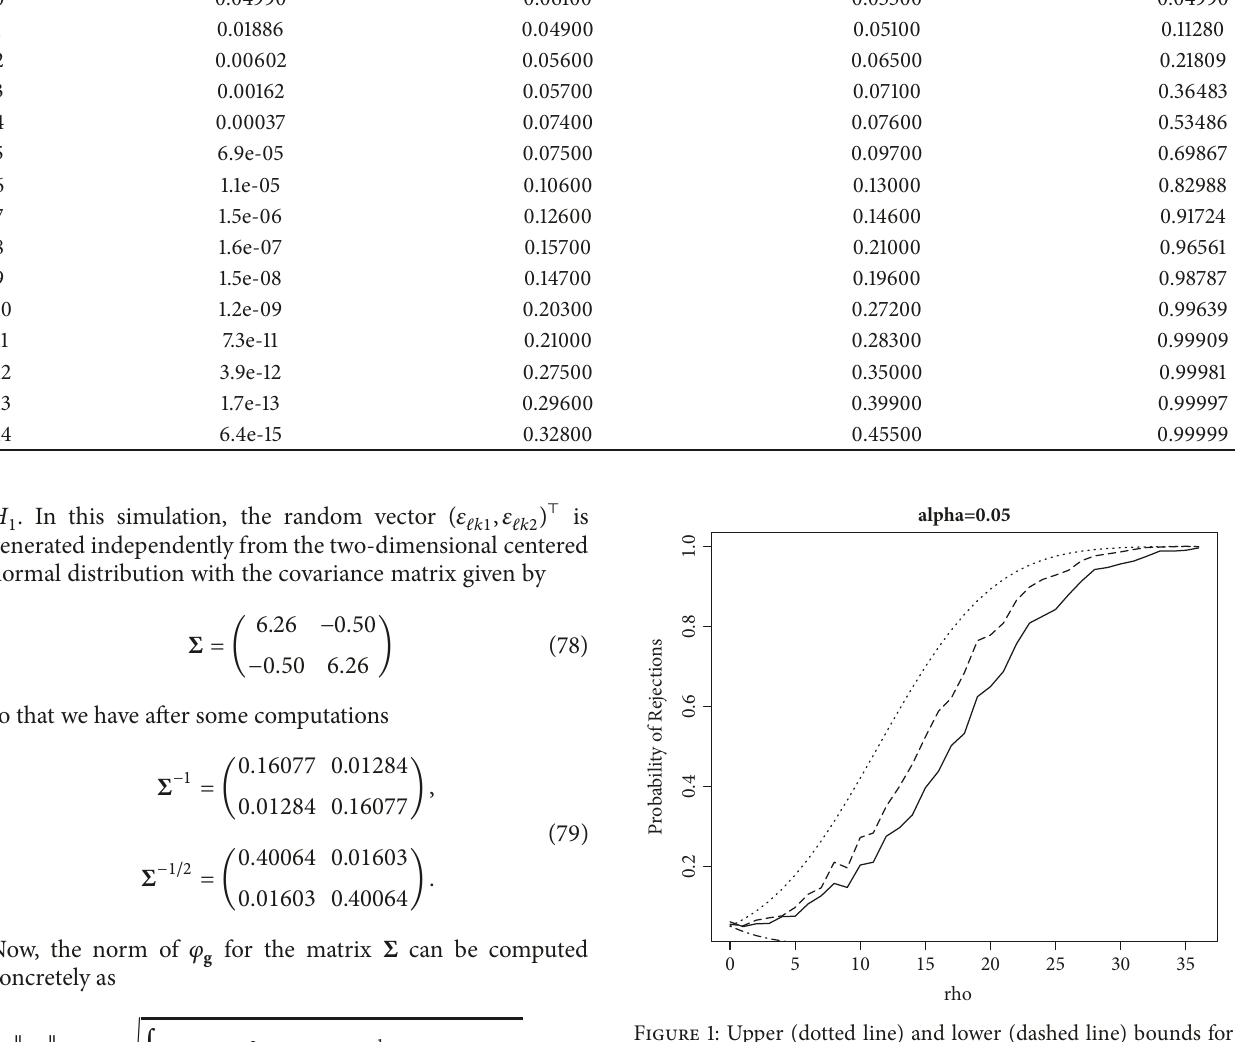
Table 1: The numerical upper and lower bounds for Ψ